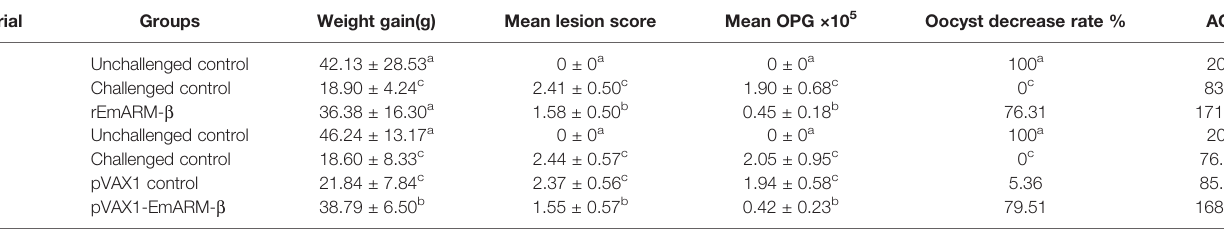
TABLE 2 | Protective ef fi cacy assessment of EmARM- b against E. maxima infections.